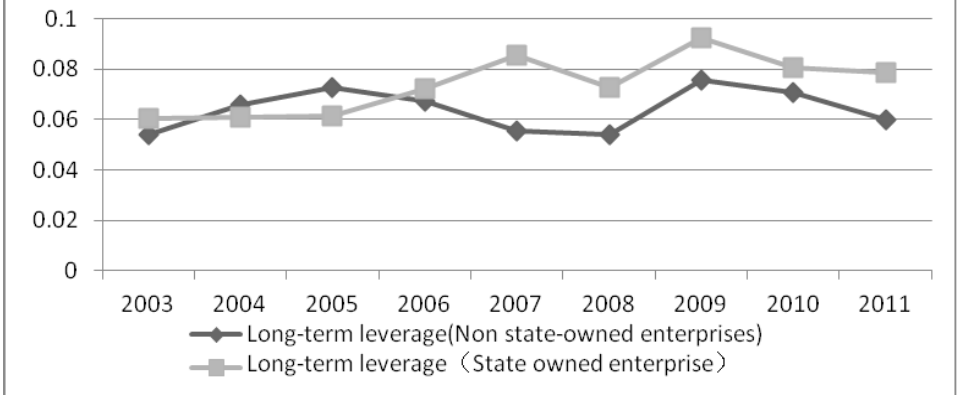
Figure 1. Long-term debt ratio of the state-owned enterprises and non-state-owned enterprises over the period 2003-2011